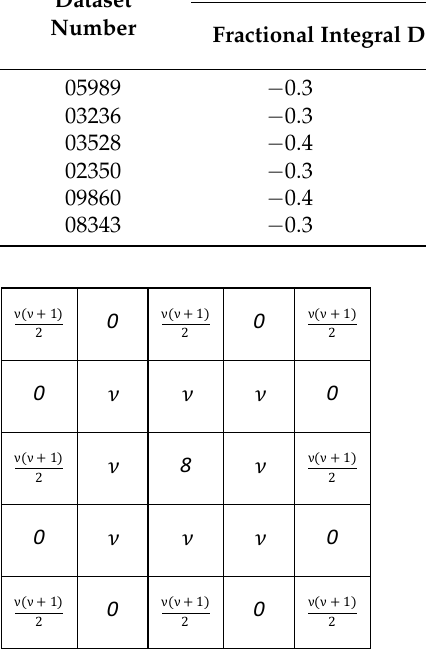
Figure 4. Fractional integral denoising operator.